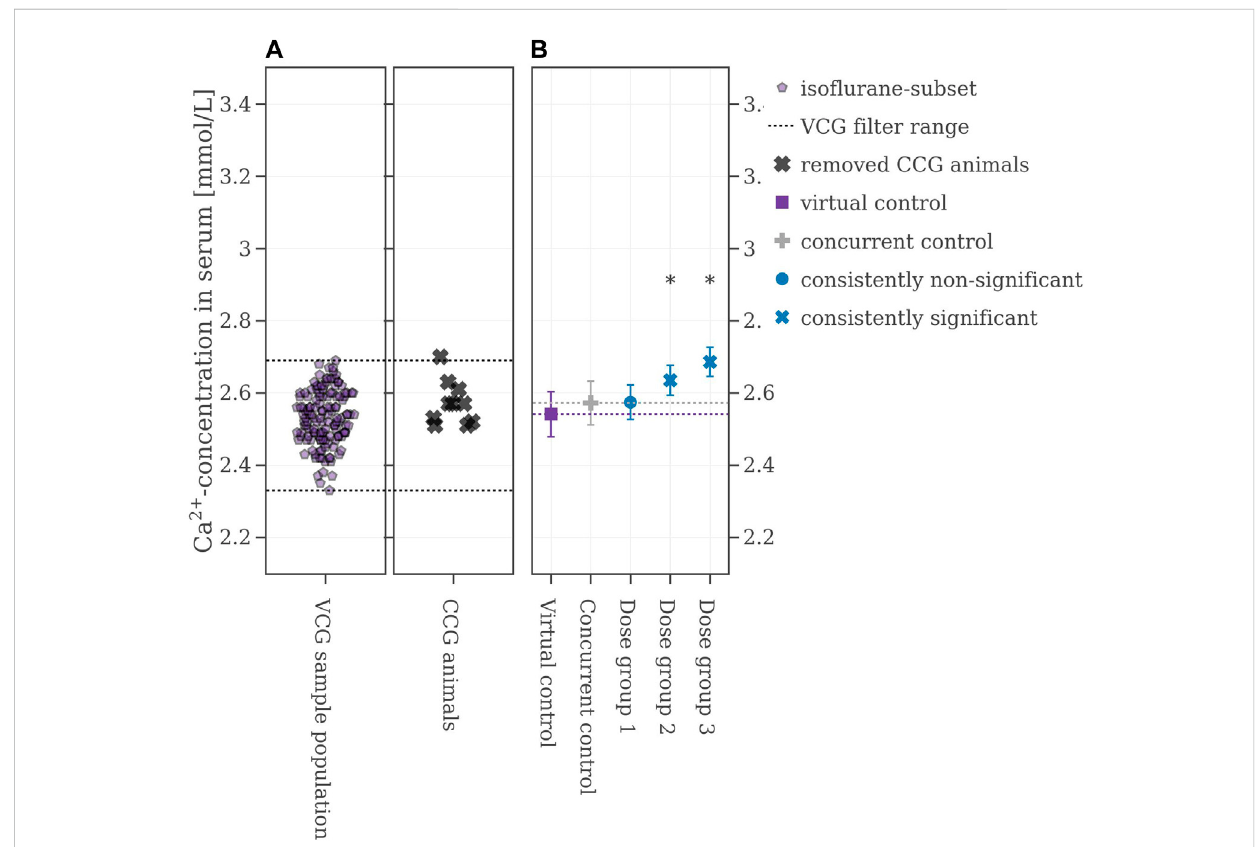
FIGURE 6 (A) Selection range of virtual control values along with concurrent control values which are removed. (B) Mean values of the legacy study and the virtual control, colored with respect to whether the original statistical results were reproduced or not. If the mean difference between a dose group and the virtual control exceeded the Dunnett-critical distance, the group was marked with an